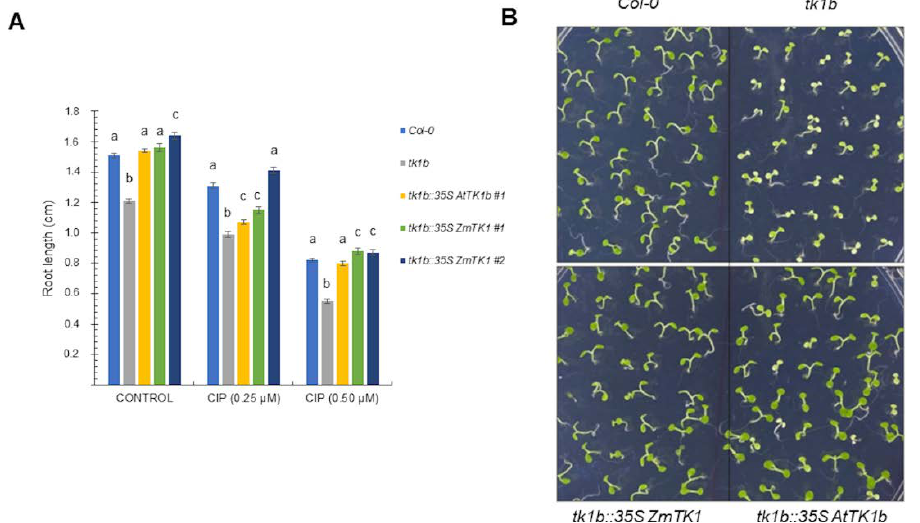
Figure 5. Expression of ZmTK1 in tk1b mutant confers tolerance to organellar genotoxin. Col-0, tk1b mutant, and tk1b mutants complemented with the native gene ( AtTK1b ) or the maize gene ( ZmTK1 ) were germinated on GB5 agar medium supplemented with ciprofloxacin (CIP) ( A ) and root length was measured in 9-day-old seedlings. Values are averages ± SEs ( n = 20) are shown, and different letters in each treatment indicate significant mean differences, as analyzed by ANOVA followed by Tukey’s comparison test ( p < 0.01). ( B ) Representative phenotypes of Col-0, tk1b mutants and complemented mutants grown in presence of 0.5 µM CIP.